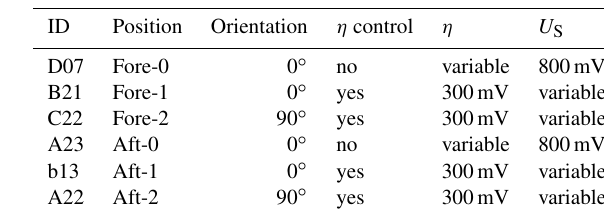
Table 1. Overview of the sensors measuring atomic oxygen on WADIS-2. Orientation is defined between electrode surface and payload